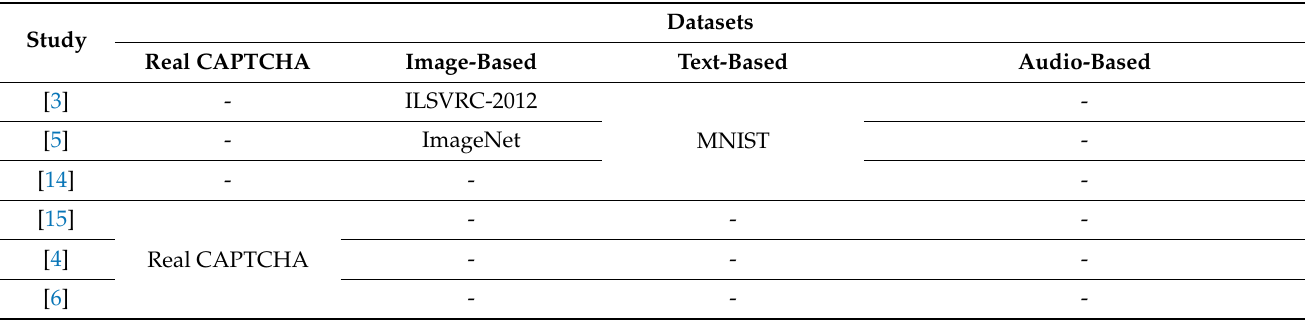
Table 3. Used datasets in the literature to generate adversarial CAPTCHAs.